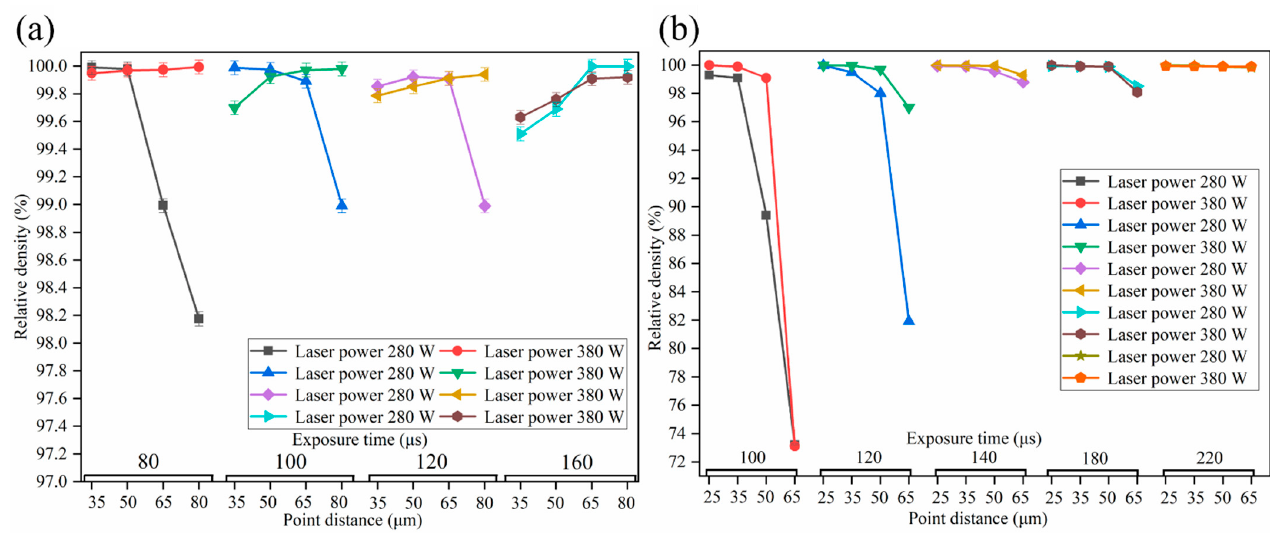
Figure 6. Relative density curve: ( a ) 50 μ m; ( b ) 150 μ m. Table 5. Summary of different layer thickness in previous studies.